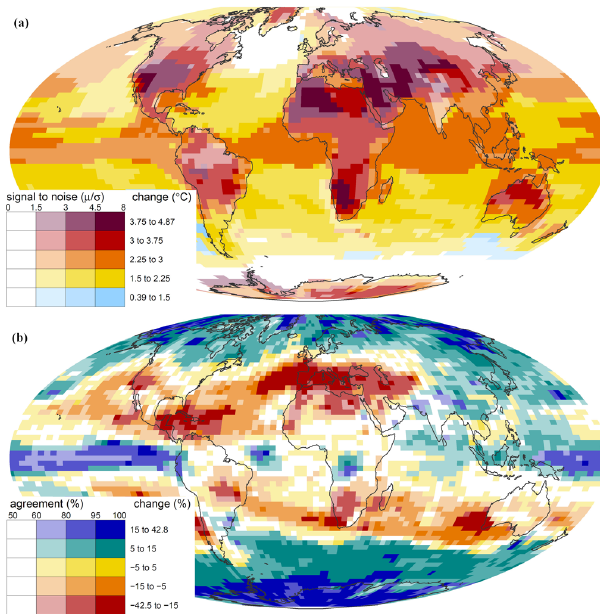
Fig. 10. (a) A synthesis of the maps shown in Fig. 6a and Fig. 6e, the different hues represent change in temperature between 1961– 1990 and 2070–2099 for the mean of the IPCC AR4 ensemble based on the SRES A1B scenario, the different saturations repre- sent signal-to-noise ( µ / σ) across the ensemble. (b) a synthesis of the maps shown in Fig. 6b and d, the different hues represent change in precipitation between 1961–1990 and 2070–2099 for the mean of the IPCC AR4 ensemble based on the SRES A1B scenario, the dif- ferent saturations represent percentage model agreement across the